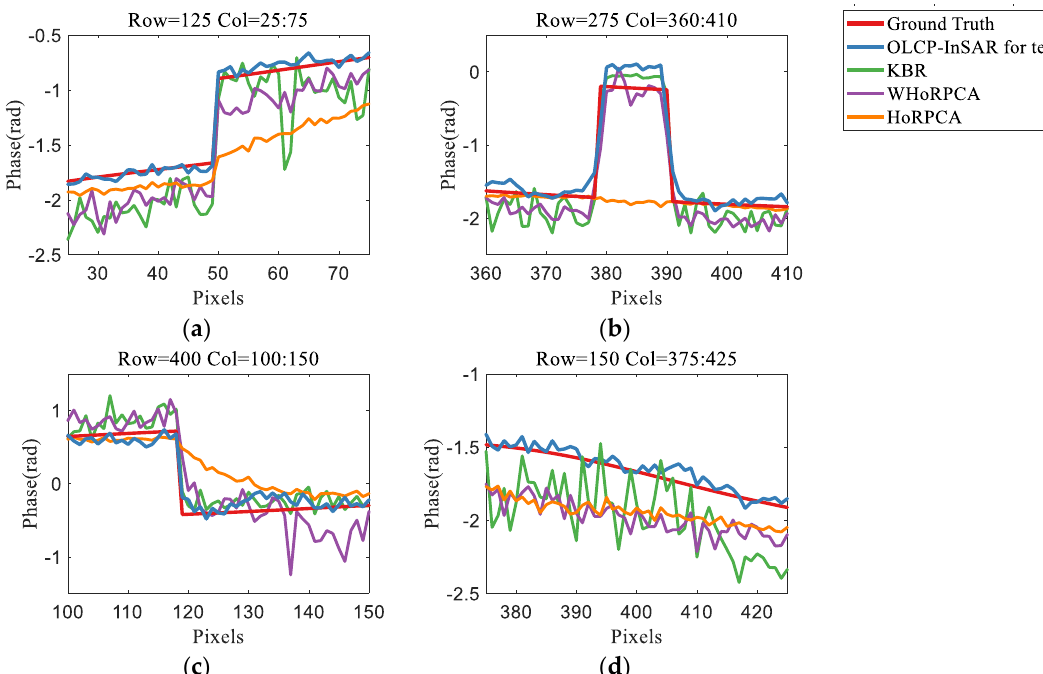
Figure 11. The filtered phase profiles with OLCP-InSAR (blue line) and other references. ( a ) The filtered phase profiles at row 125 and column 25 to 75. ( b ) The filtered phase profiles at row 275 and column 360 to 410. ( c ) The filtered phase profiles at row 400 and column 100 to 150. ( d ) The filtered phase profiles at row 150 and column 375 to 425.